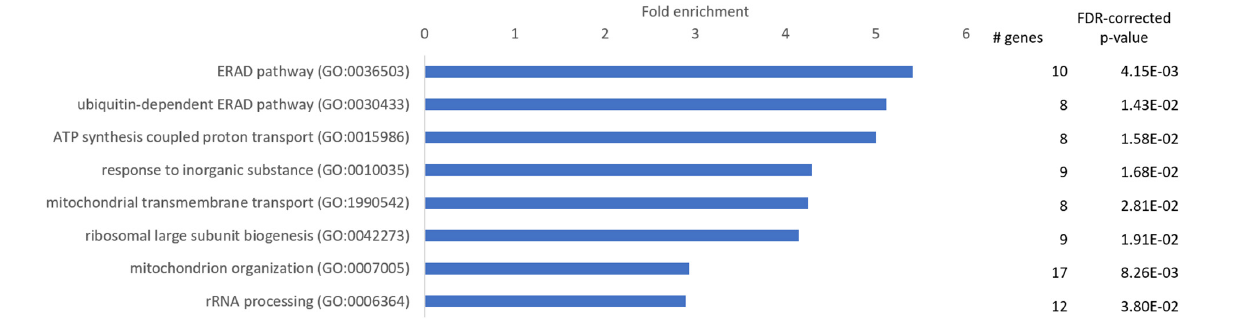
FIGURE 2 | Enriched GO-slim terms in the category “biological processes” in the neurons of the visual cortex of hooded seals compared to mice. Genes used for analysis were significantly more highly expressed in hooded seals (fold change ≥ 2). The number of hooded seal genes in every GO-slim term and the FDR-corrected p -value are